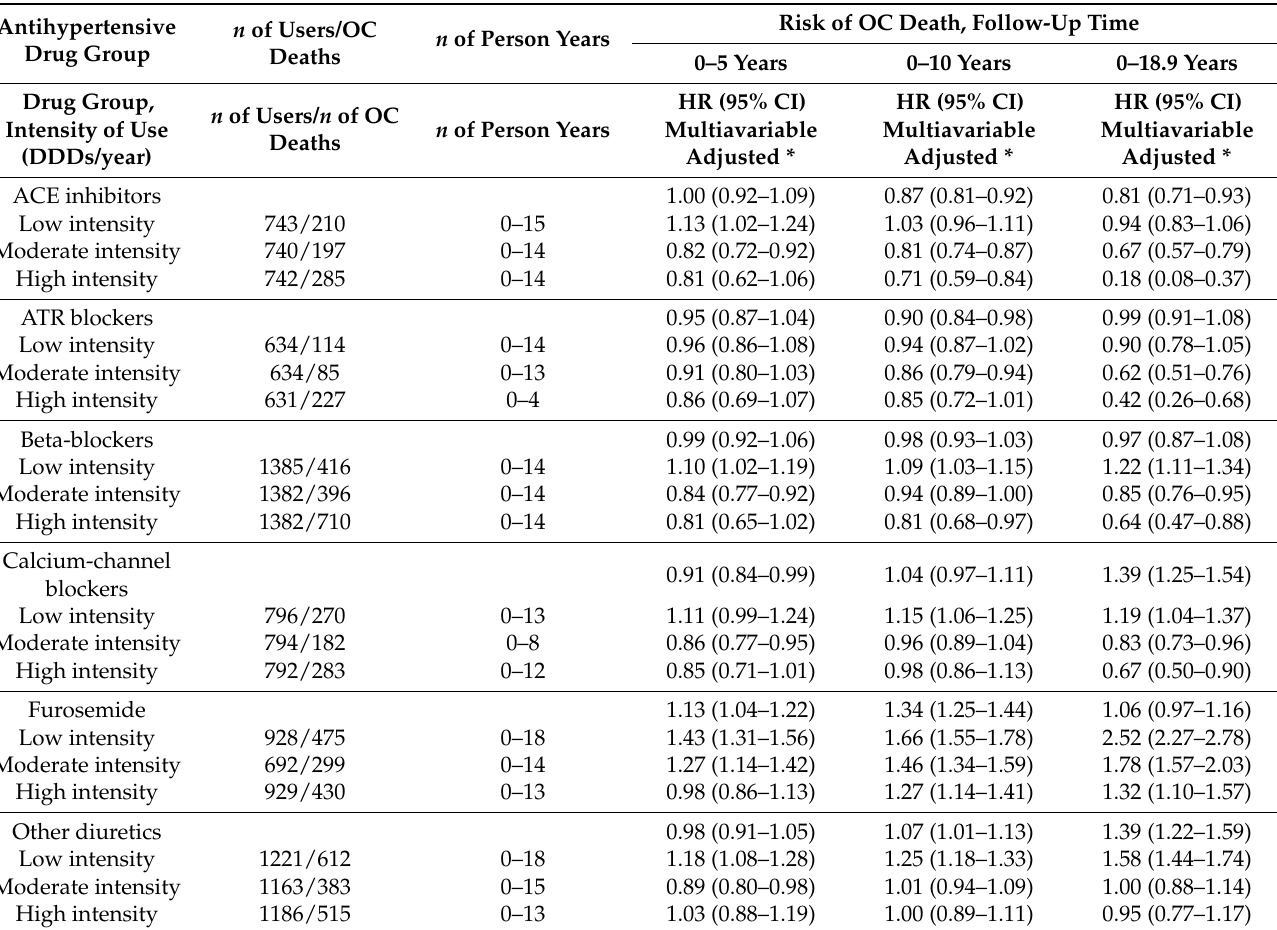
Table 3. Risk of OC death according to antihypertensive drug use after the OC diagnosis.